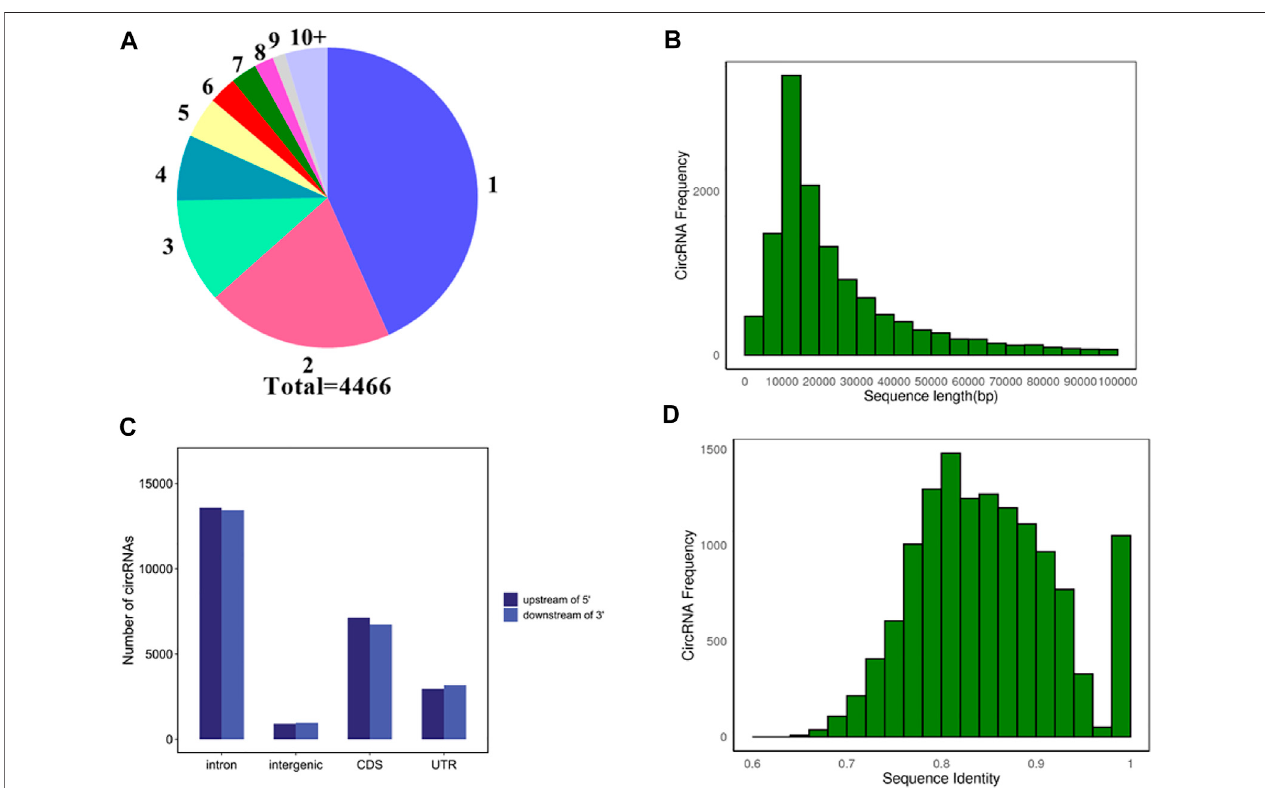
FIGURE 3 | Analysis of source genes and molecular characteristics of circRNAs. (A) Statistics of source genes. Different numbers represent different numbers of circRNAtranscripts.1,2,3 ... 10+representone,two,three ... and10+circRNAtranscripts,respectively.Differentcolorsrepresentthedifferentnumberofsourcegenes. For instance, blue represents the number ofsource genes that produce one circRNA transcript. Total 4,466 representsa total of 4,466 source genes. (B) Distribution of fl anking intron sequences lengths of circRNAs. (C) Flanking sequences of a circRNA 5 ′ end upstream and 3 ′ end downstream. (D) Distribution of sequences identi fi ed on each intron pair that are fl anking